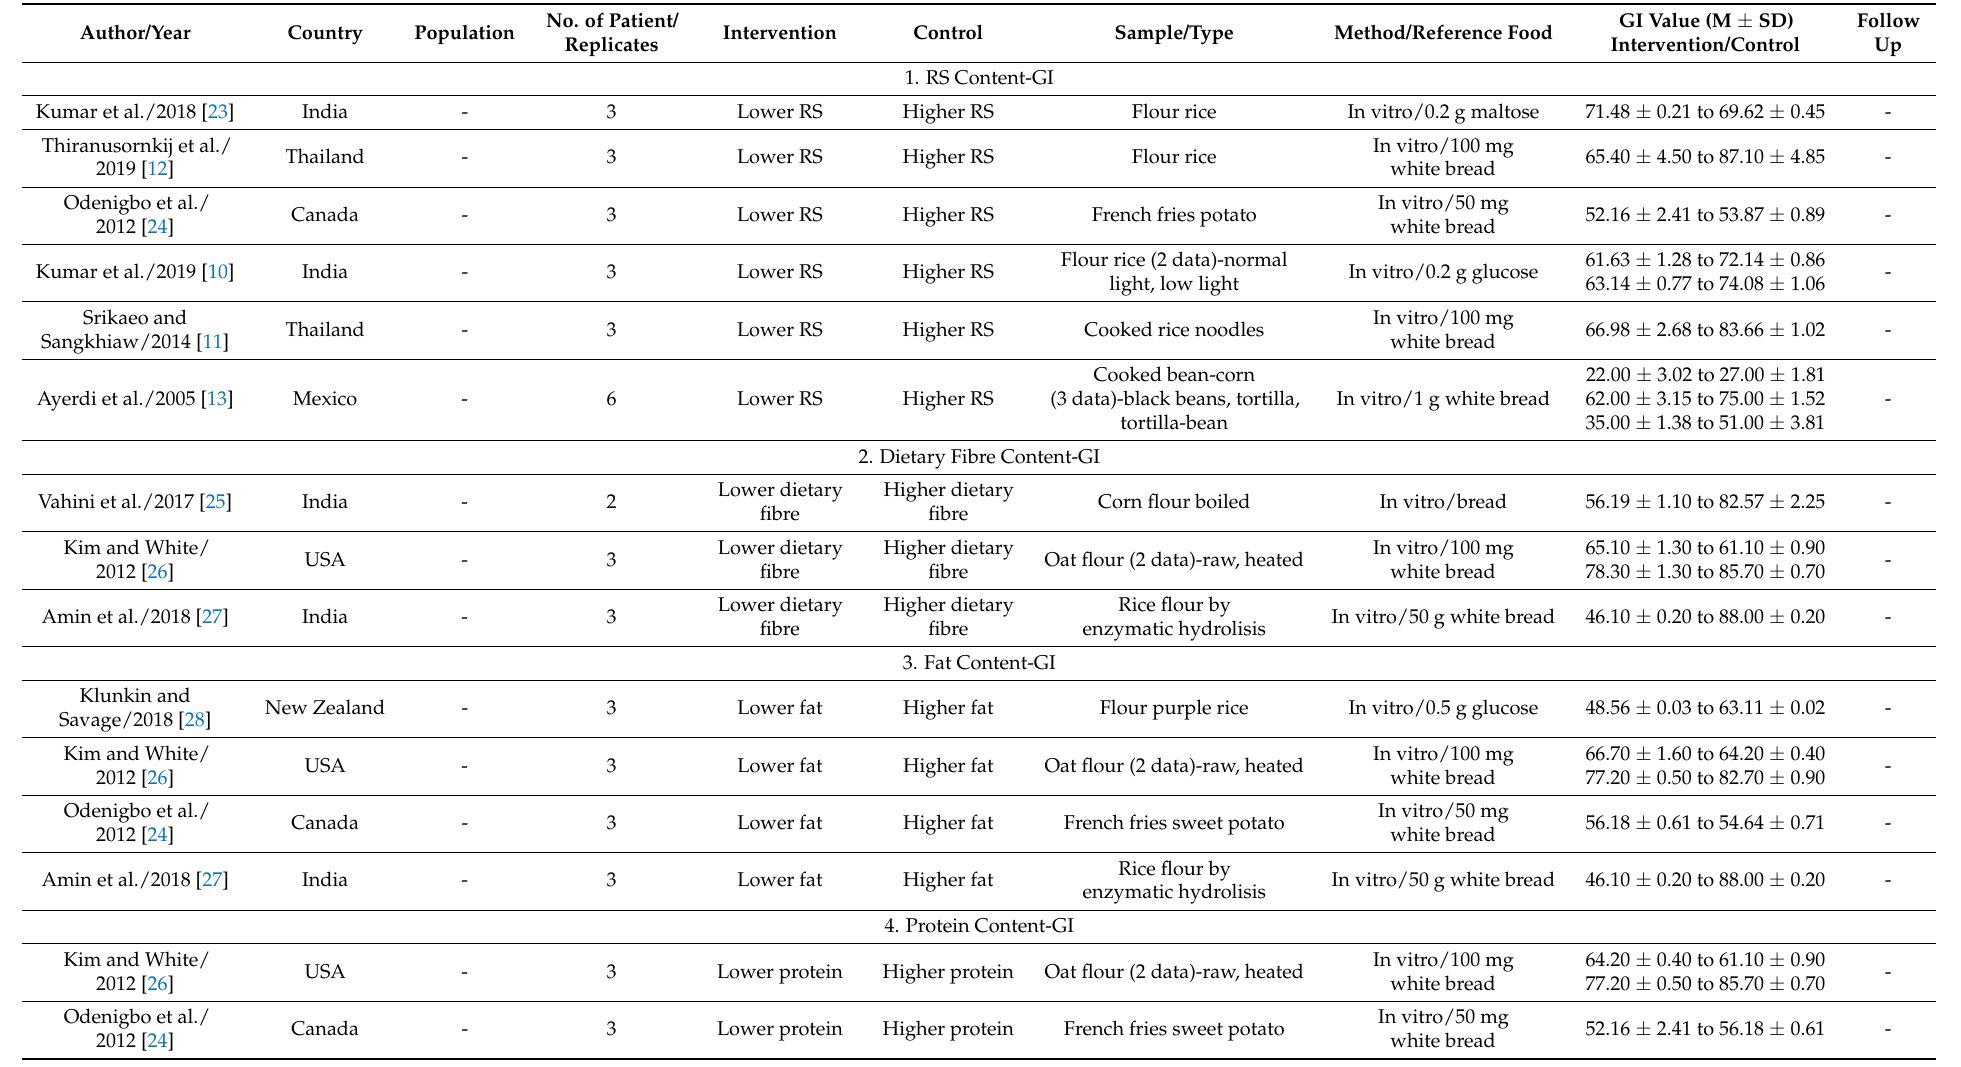
Table 2. Characteristics of in vitro studies included in the systematic review and meta-analysis. RS: resistant starch; GI: glycemic index; M: mean; SD: standard